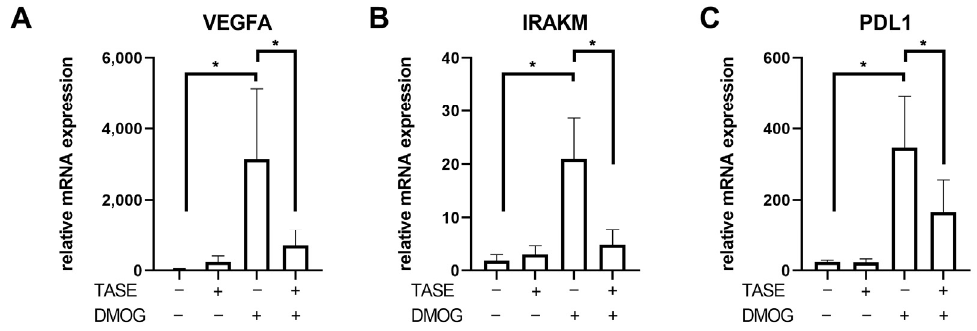
Figure 5. Expression of HIF-1 α pathway related genes in monocytes treated with DMOG. Monocytes from HV ( n = 5) were stimulated with 100 µ M of DMOG for 16 h in combination or not with 3 µ g/mL of TASE. Relative expressions of VEGFA ( A ), IRAKM ( B ), and PDL1 ( C ) are shown. *, p < 0.05 in paired t test. Bars represent mean ± SD.